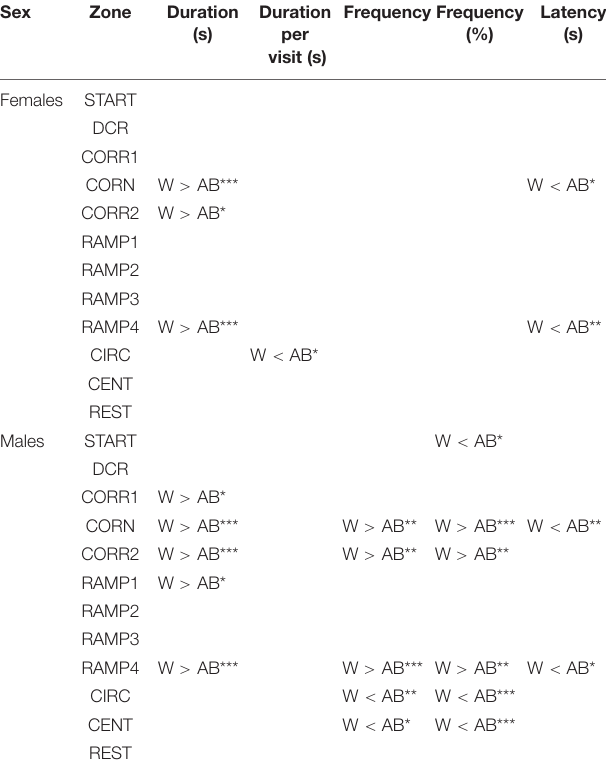
TABLE 1 | Pairwise comparisons between strains and sexes in the zones of the zMCSF in AB and wild (W) zebrafish, separating males and